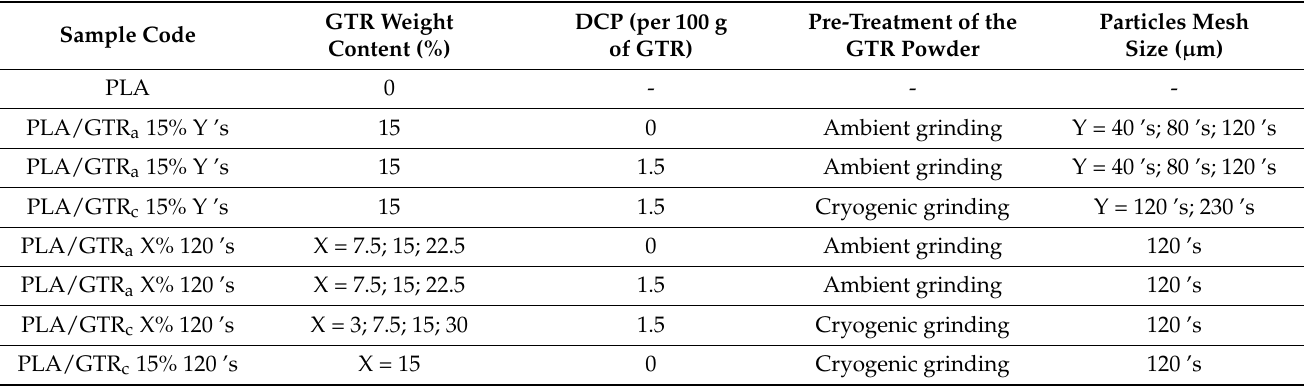
Table 1. Code of the processed blends using various GTR grinding processes, sieving meshes and PLA/GTR quantities. All blends were prepared with 0.2 wt% Irganox ® 1010. GTR a states for ambient grinded GTR and GTR c states for cryo- grinded